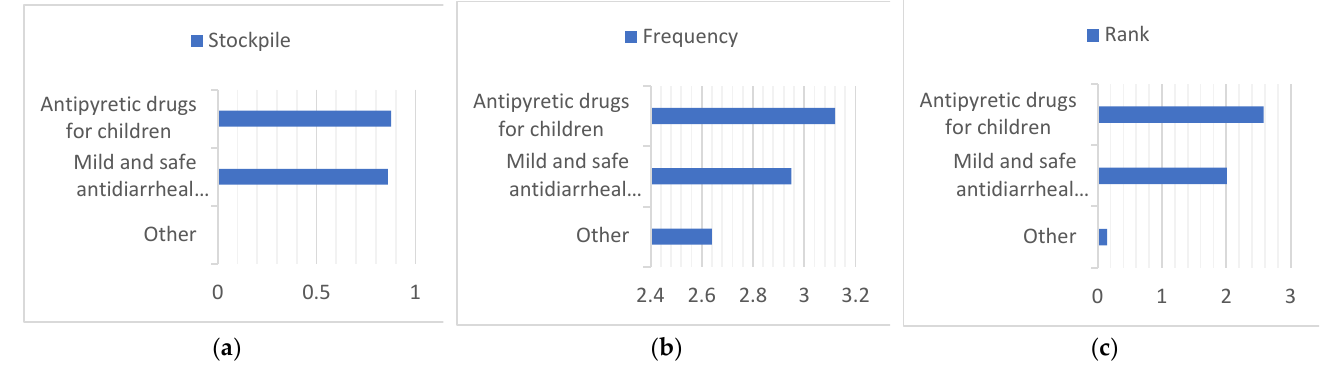
Figure 9. Summary of the child-specific medication stockpile, frequency of medication use, and ranking of medication importance for the child’s family. ( a ) Stockpile, ( b ) Frequency, ( c ) Rank.